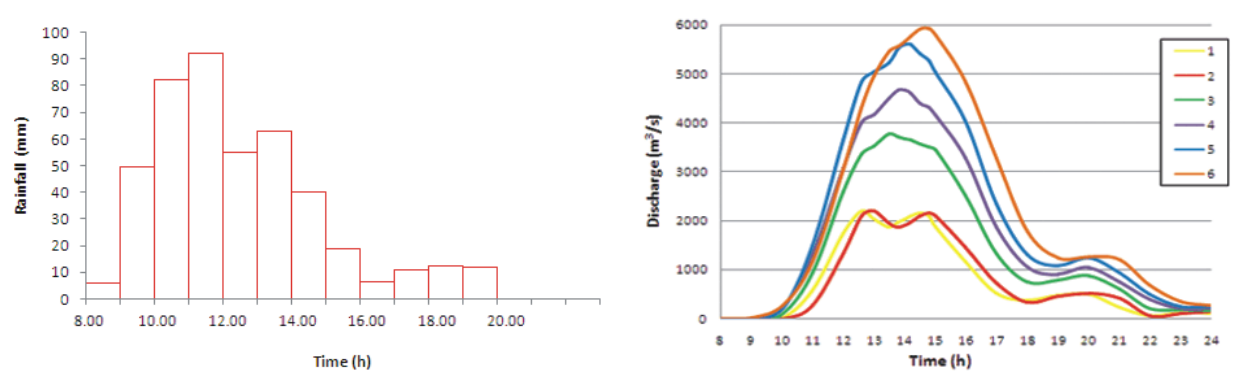
Fig. 5. The rainfall data used in the hydrologic model simulation and the resultant hydrographs. The different colors represent the corre- sponding station as the interview stations.